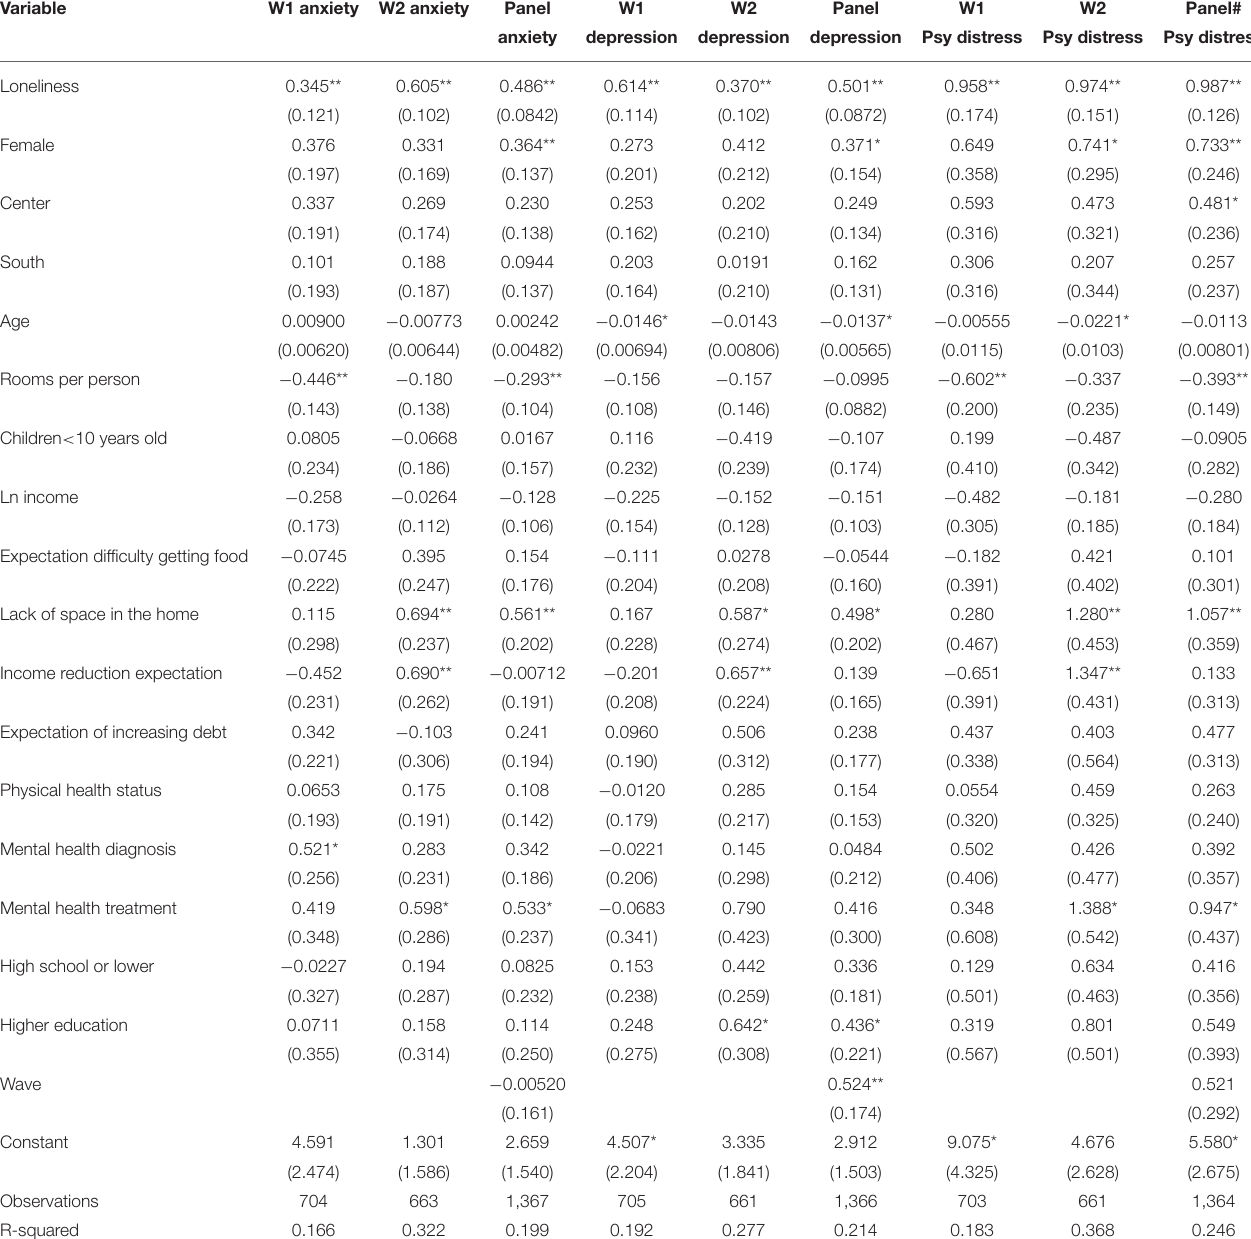
TABLE 4 | Regression models (W1, W2 and panel data).